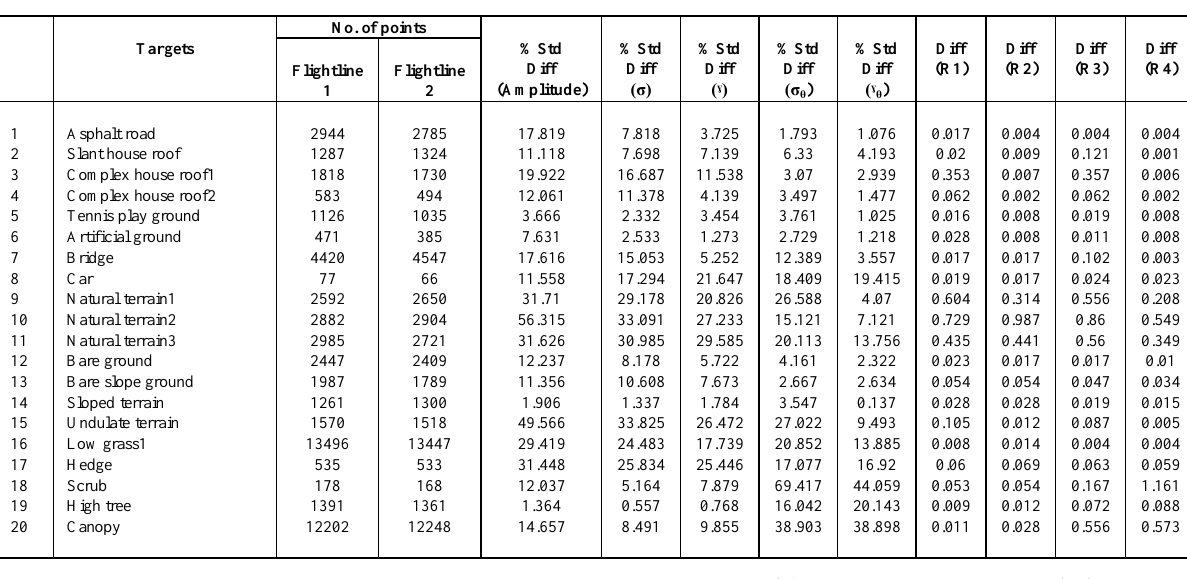
Table 1. Results of the standard deviation difference in percentage and the ratio (R) of the variation coefficients ( V C ) delivered from all tested targets.